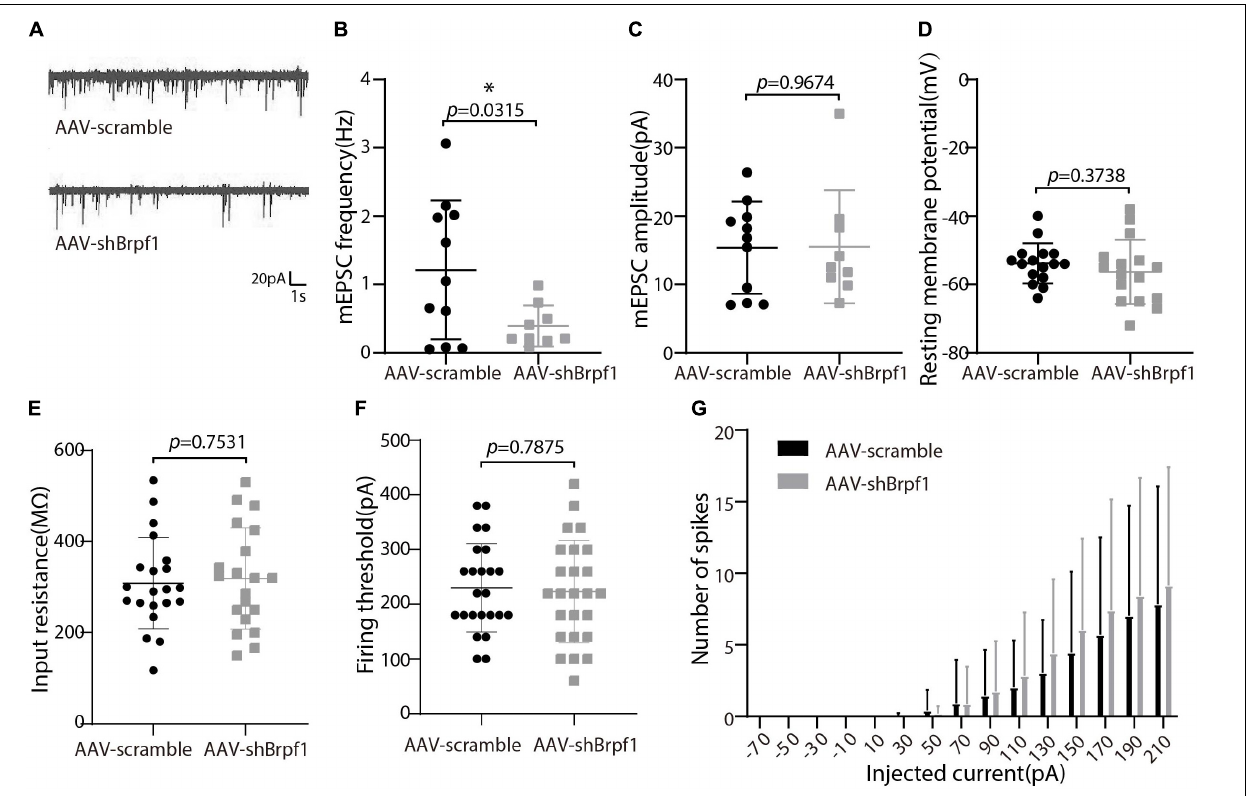
FIGURE 2 | Mild knockdown of Brpf1 led to decreased mEPSC frequency. (A) Representative traces of mEPSCs recorded in cultured primary hippocampal neurons of AAV-scramble or AAV-shBrpf1 group, scale bar, 20 pA and 1 s. (B) Statistical comparison of mEPSC frequency between AAV-scramble and AAV-shBrpf1 groups (AAV-scramble, n = 11 neurons; AAV-shBrpf1, n = 9 neurons; p = 0.0315). (C) Statistical comparison of mEPSC amplitude using the same dataset as (B) ( p = 0.9674). (D) Comparison of RMP between the two groups (AAV-scramble, n = 16 neurons; AAV-shBrpf1, n = 16 neurons; p = 0.3738). (E) Comparison of input resistance (AAV-scramble, n = 21 neurons; AAV-shBrpf1, n = 20 neurons; p = 0.7531). (F) Comparison of firing threshold (AAV-scramble, n = 25 neurons; AAV-shBrpf1, n = 24 neurons; p = 0.7875). (G) The number of spikes displayed against depolarizing current steps of increasing amplitude with injected currents ranging from –70 to 210 pA at 20-pA intervals (AAV-scramble, n = 25 neurons; AAV-shBrpf1, n = 24 neurons). * p <